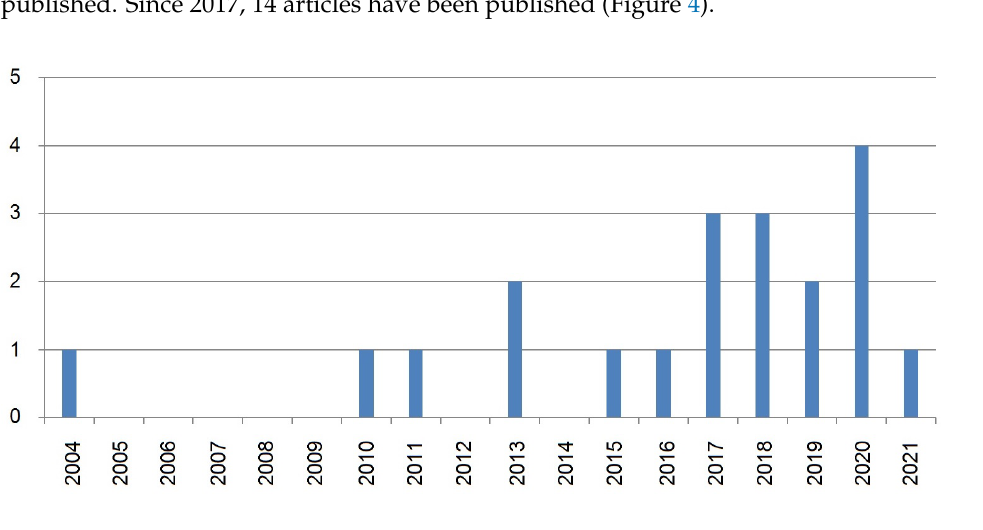
Figure 4. Number of cases studied per